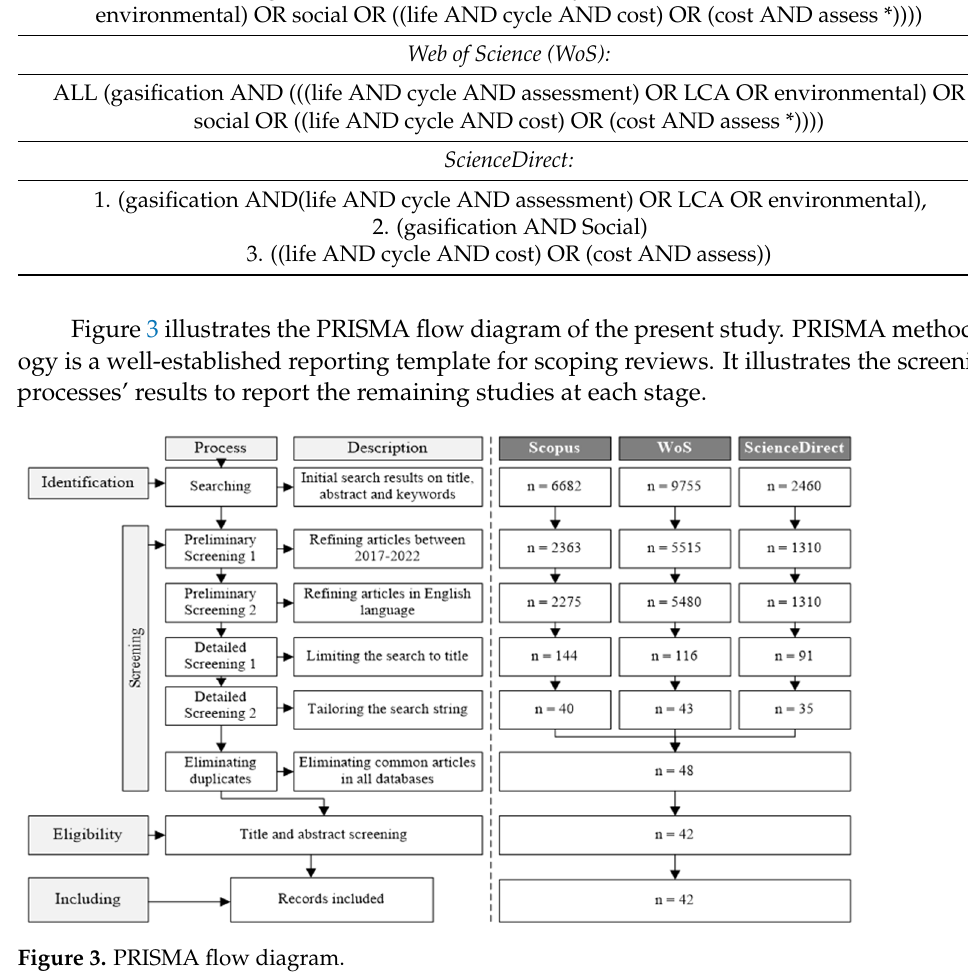
Figure 3. PRISMA flow